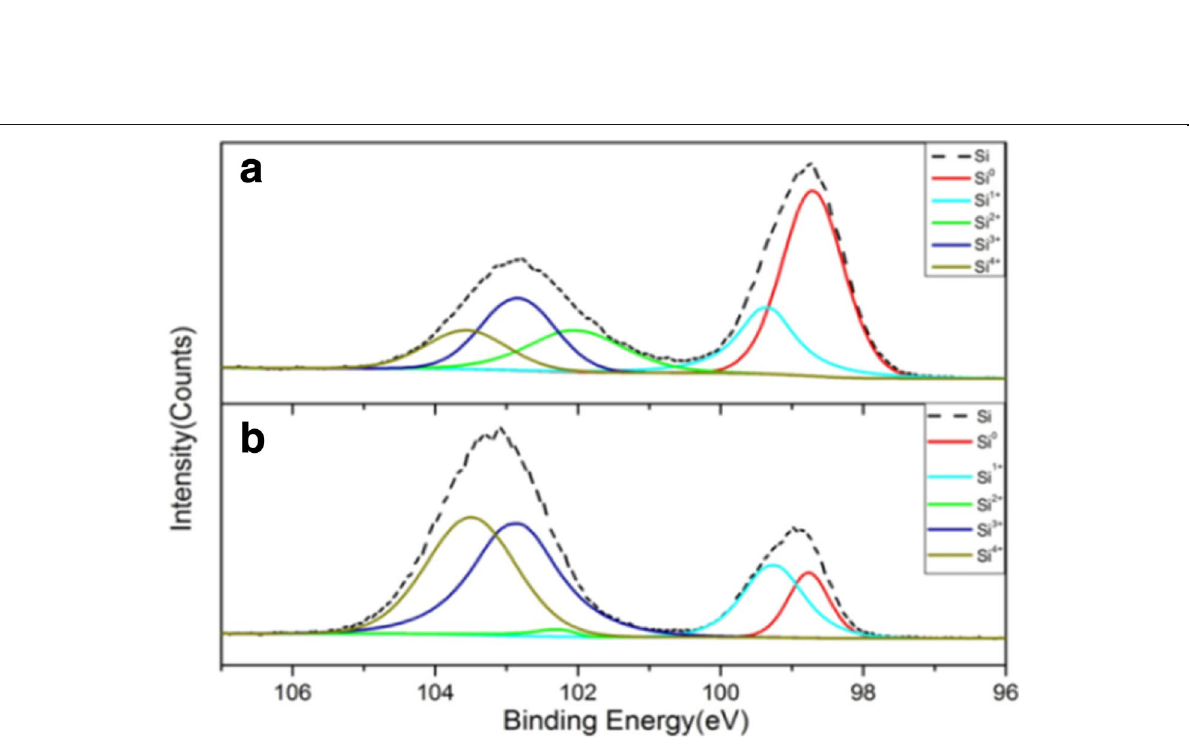
Fig. 2 Si 2p XPS spectra (dash line) and their deconvolution fitting into five chemical states (from Si0 to Si4+, color lines) of the Si 2p for Si sludge in a and nano-Si/SiOx sample in b ,